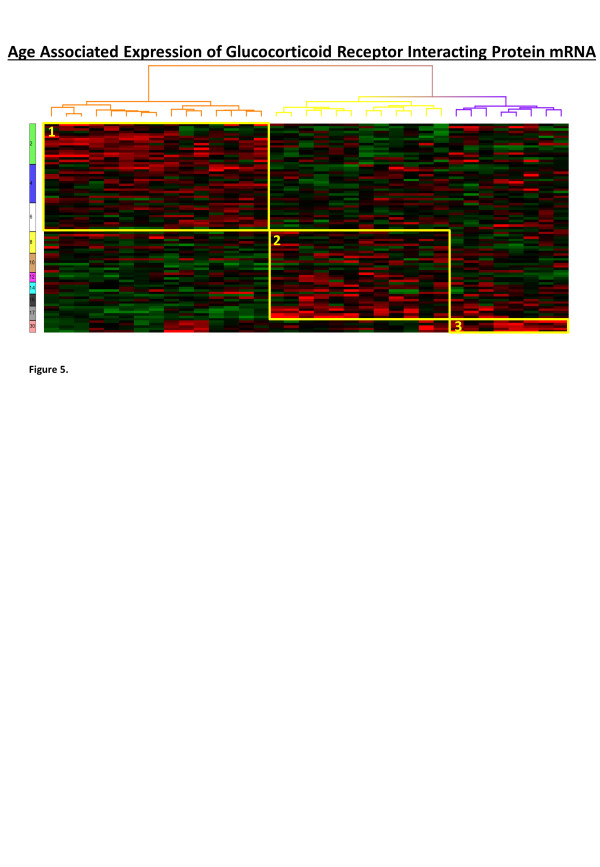
Heat map of age-associated changes in the expression of genes for glucocorticoid receptor interacting proteins (n = 338) in 87 individuals (0.2 to 29.3 years of age - average 7.7+/−7.0 yrs); 35 gene expression probes were significantly associated with age (ANOVA, false discovery rate (FDR) corrected p-value, q < 0.2). Supervised hierarchical clustering using Kendell’s dissimilarity and Ward’s method identified three main clusters of gene expression probes correlating with ≤6 years of age [infancy, early childhood group (15 probes)]; >6 to ≤17 years of age [late childhood, puberty group (12 probes)] and >17 to <30 years of age [adulthood (8 probes)]. Gene expression is shown between +2.5 fold and −2.5 fold, red = increase in gene expression, green = decrease in gene expression.